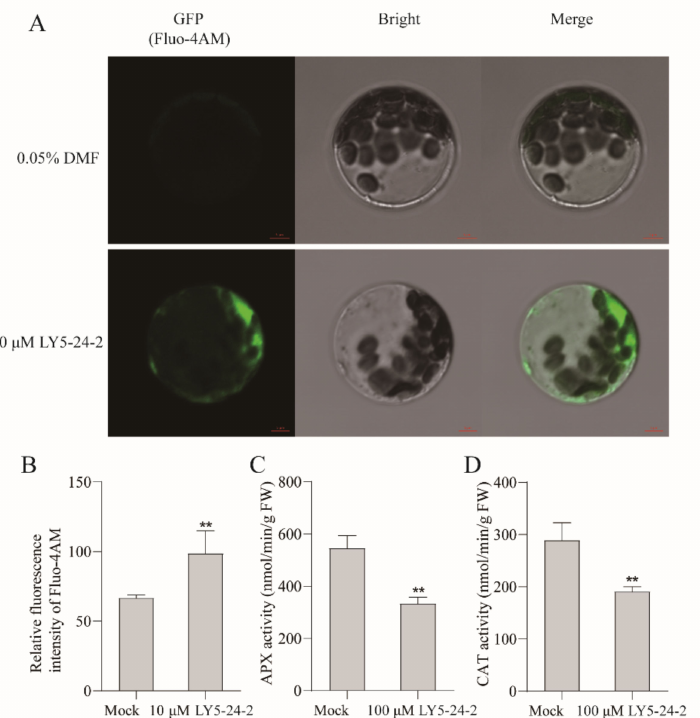
Figure 4. LY5-24-2 promoted the accumulation of Ca 2+ , inhibited APX and CAT activity in A. thaliana at 24 h after a treatment with 100 µ M of LY5-24-2. ( A ) Ca 2+ content analysis. ( B ) Relative fluorescence intensity statistics of A. ( C ) APX activity. ( D ) CAT activity analysis. Data are shown as the mean of three biological replicates ± SD. The * represent significant difference (** p < 0.01, Student’s t -test). 2.4. Analyses of Differentially Expressed Genes (DEGs) in A. thaliana after a LY5-24-2